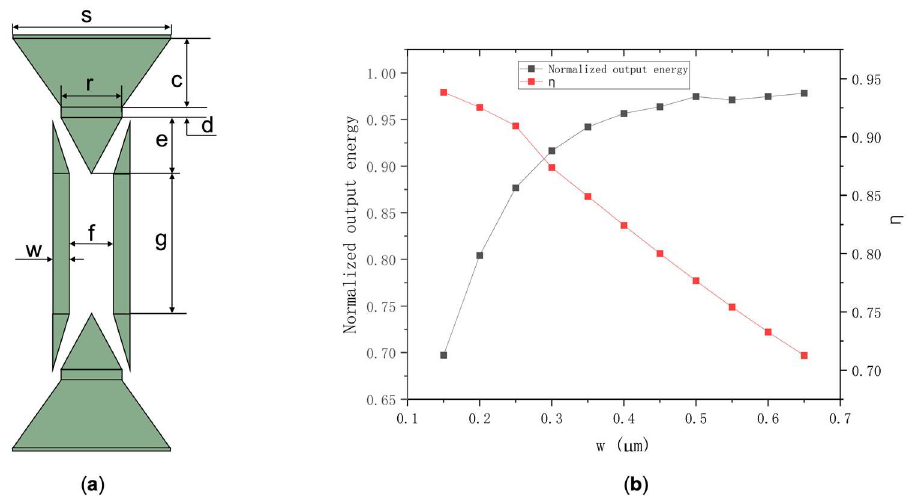
Figure 4. ( a ) Schematic of the coupling structure. ( b ) 𝐼 (cid:3042)(cid:3048)(cid:3047) and η corresponding to different slot cross-section sizes.